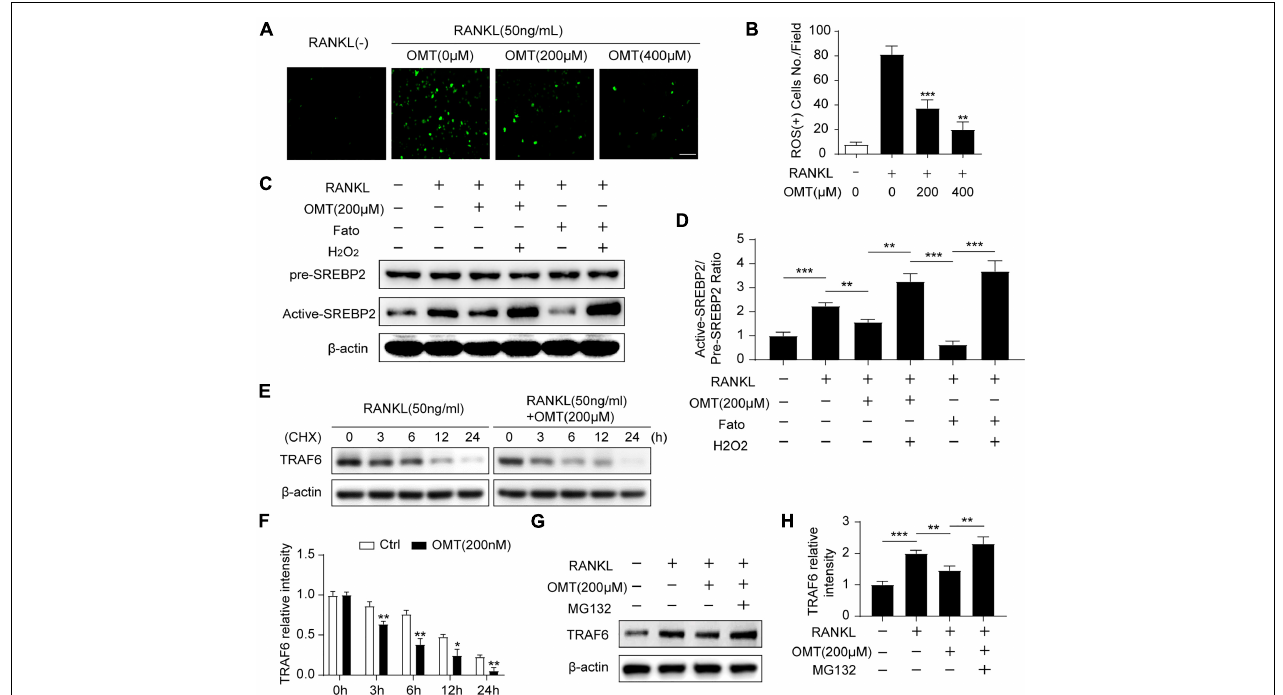
FIGURE 4 | OMT inhibits SREBP2 activation via down-regulating ROS levels during osteoclastogenesis. (A) BMMs were treated with RANKL and different concentrations of OMT for 3 days, DCFH-DA was used to examine the intracellular ROS levels and representative images were shown. Scale bar = 100 µ m. (B) Quantification of ROS-positive cell numbers per field ( n = 5 per group). (C) BMMs were treated with RANKL, OMT, Fatostatin (Fato), and H 2 O 2 as indicated, the level of pre-SREBP2 and active-SREBP2 was detected with western blots. (D) Quantification of the ratios of band intensity of active-SREBP2 relative to pre-SREBP2 ( n = 3 per group). (E) BMMs were treated with or without 200 µ M OMT in the presence of RANKL, and cultured with CHX for the indicated hours, the level of TRAF6 was examined by western blots. (F) Quantification of the ratios of band intensity of TRAF6 relative to β -actin ( n = 3 per group). (G) TRAF6 expression in BMMs incubated with the proteasomal inhibitor MG 132 in the presence or absence of RANKL and OMT. (H) Quantification of the ratios of band intensity of TRAF6 relative to β -actin ( n = 3 per group). Data were presented as means ± SD. * p < 0.05, ** p < 0.01, *** p < 0.001.